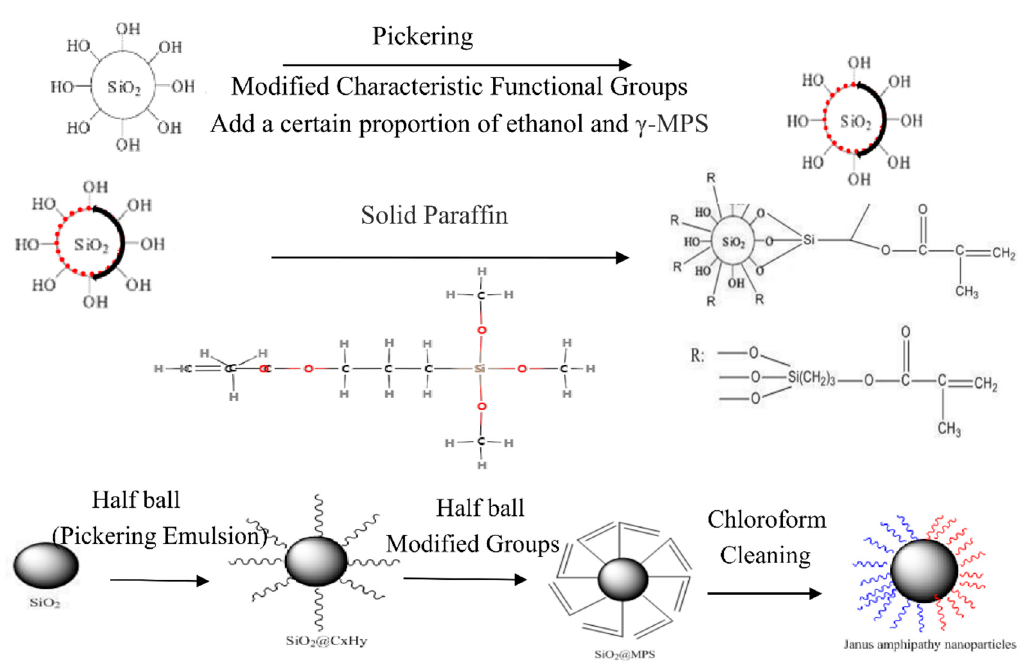
Figure 1. Synthesis scheme of asymmetric amphiphilic nanoparticles.